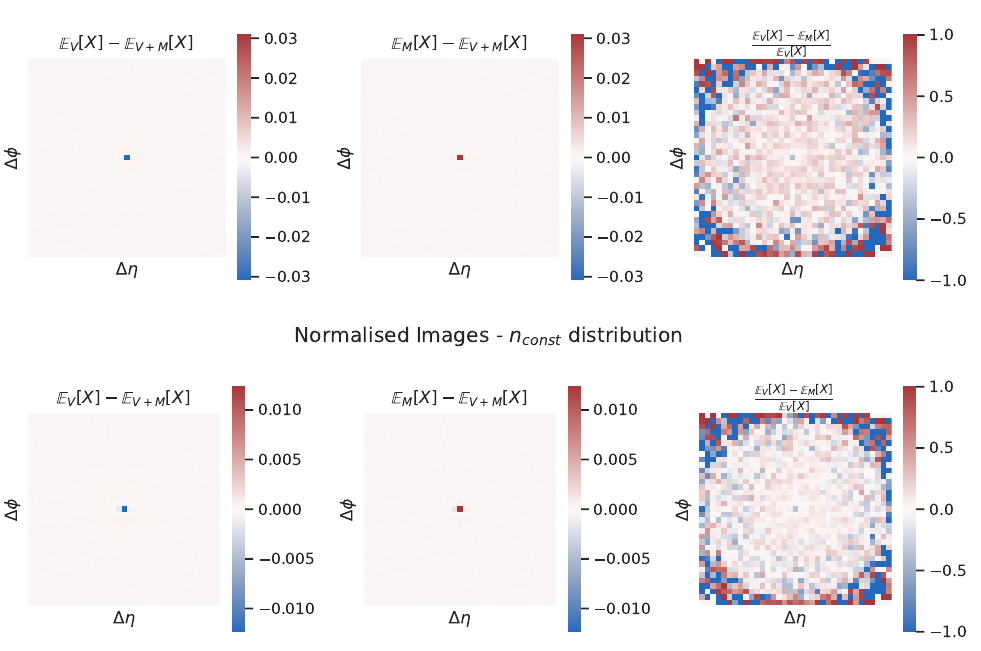
Figure 4 . Representation of the deviation from the mean (top) jet transverse momentum and (bottom) number of jet constituents in the (∆ η, ∆ φ ) -plane for the (left) Vacuum sample, (center) Medium sample and (right) the difference between the mean Vacuum and Medium images, relative to Vacuum. The images are individually normalised to the total jet transverse momentum and to the total number of jet